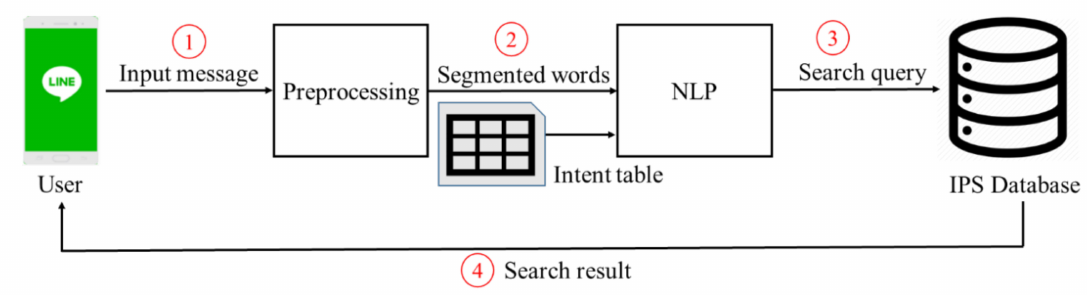
Figure 2. The architecture of